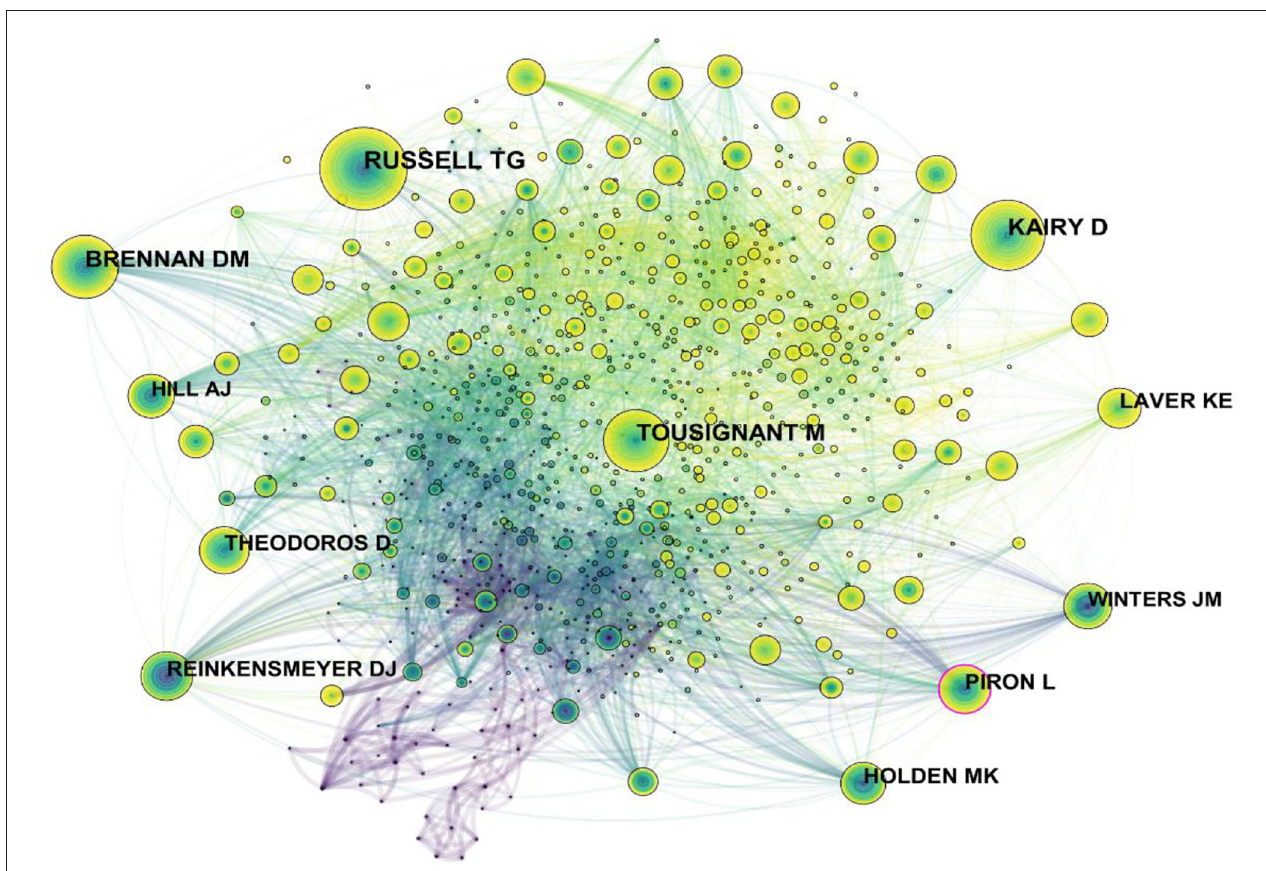
FIGURE 6 | Map of cited authors related to telerehabilitation from 2000 to 2021.